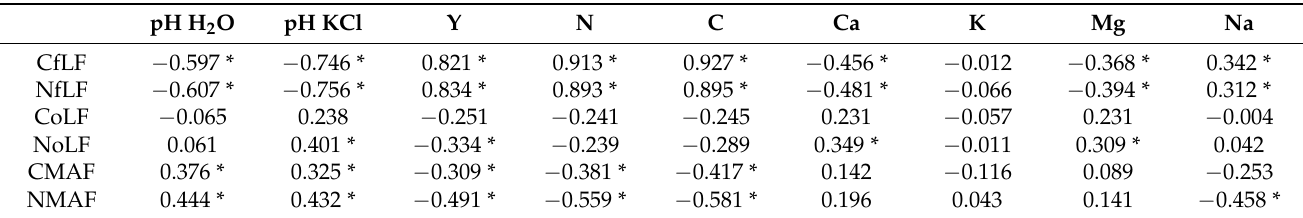
Figure 2. Nitrogen of different fraction of soil organic matter in soils under influence of different forest stands in altitude gradient (NfLF—nitrogen of free light fraction (g kg − 1 ), NoLF—nitrogen of occluded light fraction (g kg − 1 ), NMAF—nitrogen of mineral associated fraction (g kg − 1 ); ( A )—soils under influence of beech, ( B )—soils under influence of fir; small letters mean significant differences in altitude gradient (a, b)). Table 3. Correlation between soil organic matter fractions and soil